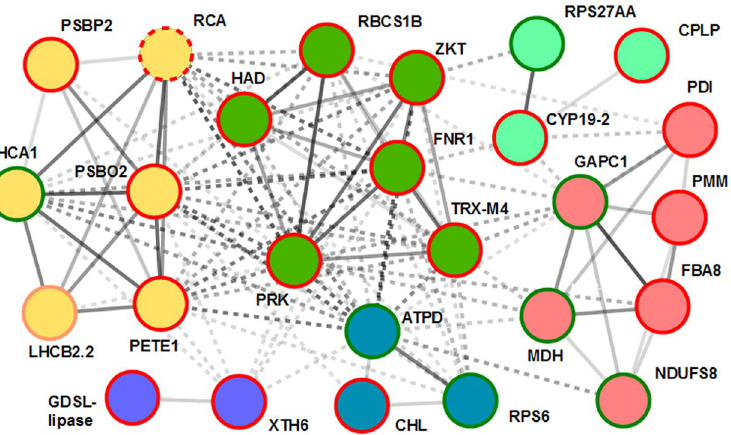
Figure 5. A protein interaction network using A. thaliana proteins most closely related to the proteins (groups 1 and 4) that were differentially expressed in sunflower shoots germinated from the seeds treated with vacuum, CP or EMF radiation. The protein interaction network was built using the String database. Circles connecting solid and dashed lines indicate protein interactions within and between clusters, respectively. Circle colors represent protein clusters assigned based on the protein interaction data. Circle line color represents a decrease (green), increase (red) or contrasting regulation of protein abundance for different proteoforms (orange) compared to control. Dashed circle line indicates regulation specific to the EMF